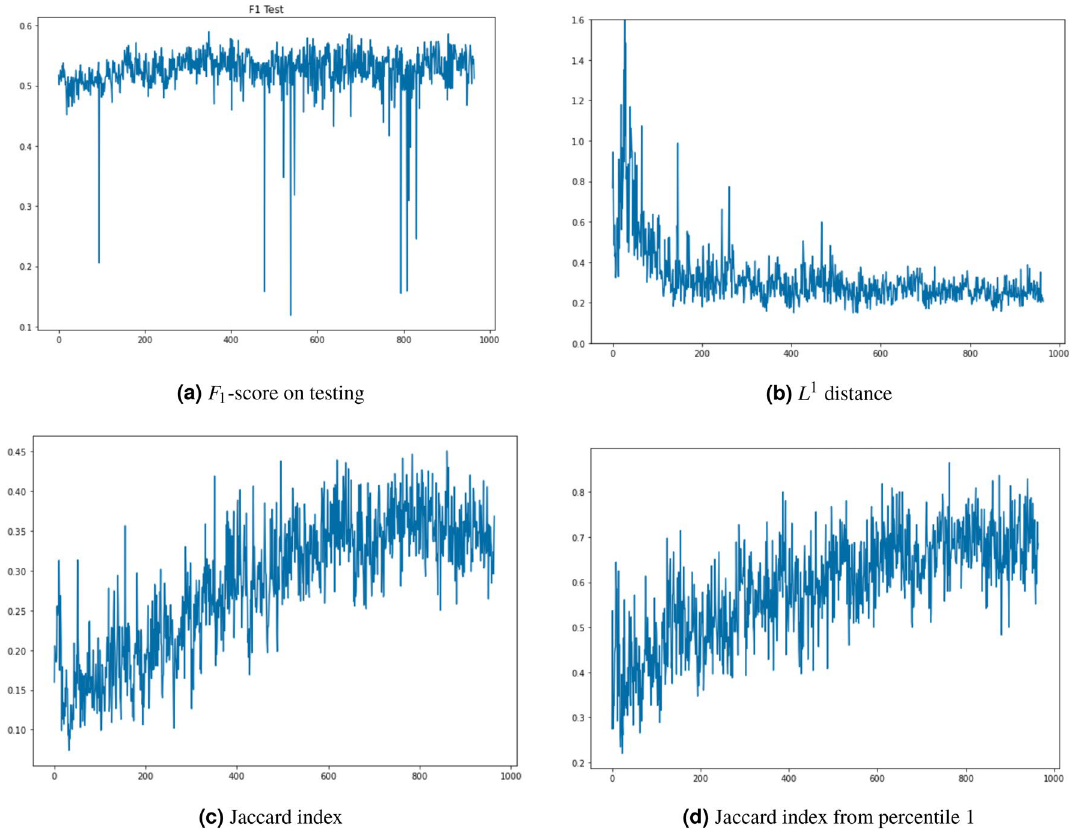
Figure 4. Evolution of F 1 -score on testing, L 1 distance and Jaccard index using GAN generator for label 0. The x -axis represents the GAN training